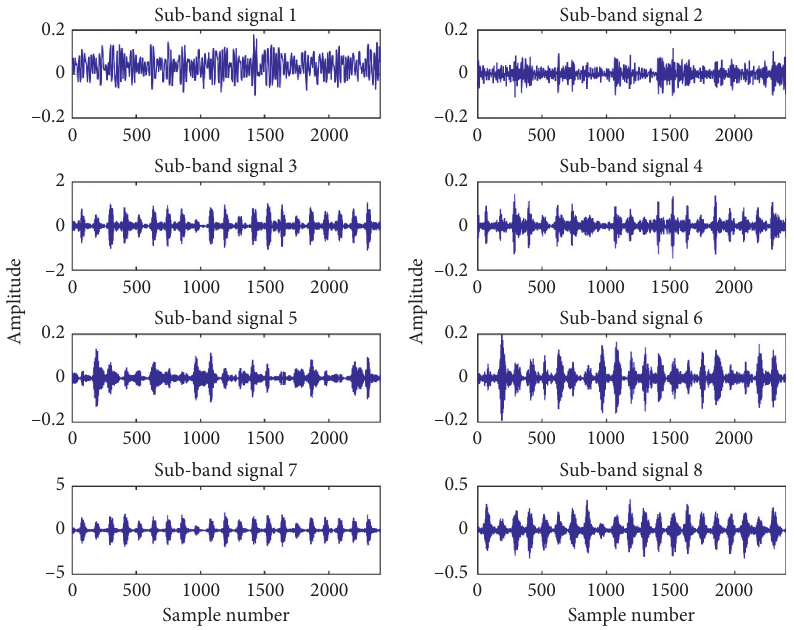
Figure 11: DTCWPT results of the sample with the minor outer race fault.